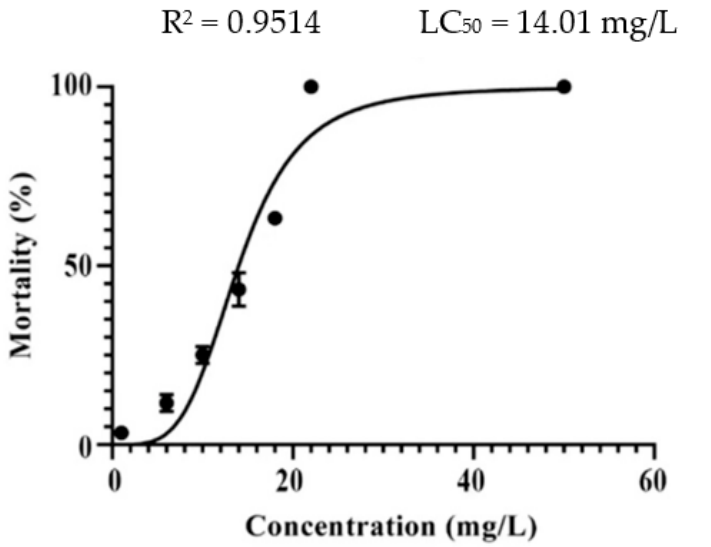
Figure 3. Zebrafish embryo mortality rates after exposure to 14h .